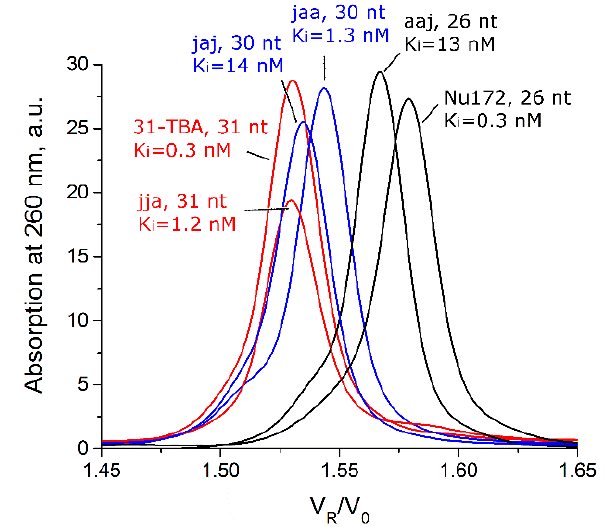
Figure 6. Comparison of different monomeric forms of bimodular aptamers in size-exclusion high performance liquid chromatography. Aptamers with equal lengths are colored identically. V R /V 0 is relative retention volume. Ki: is apparent inhibitory constant from [9].